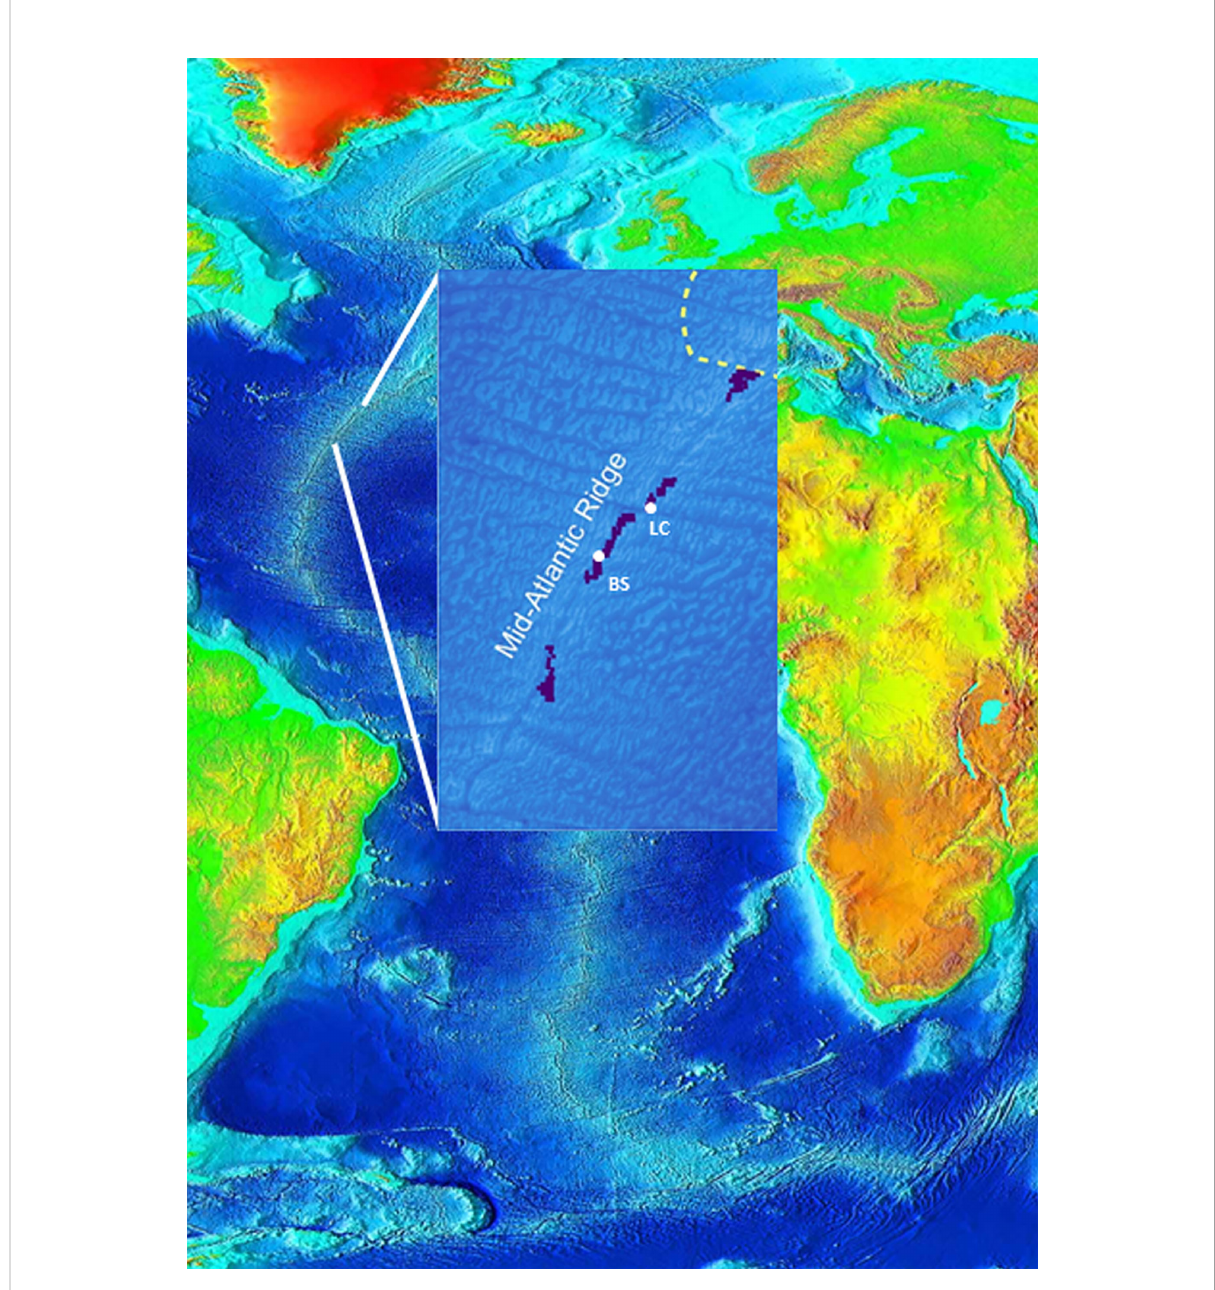
FIGURE 1 Location of the Polish contract area (PECA) on the Mid-Atlantic Ridge; LC, Lost City; BS, Broken Spur; dark squares mark exploration blocks; dotted yellow line marks the boundary of Portugal ’ s Extended Continental Shelf (based on imagery available from NOAA, http:///www.ngdc. noaa.gov/mgg/image/2minrelief.html and ISA, https://isa.org.jm/ fi les/ fi